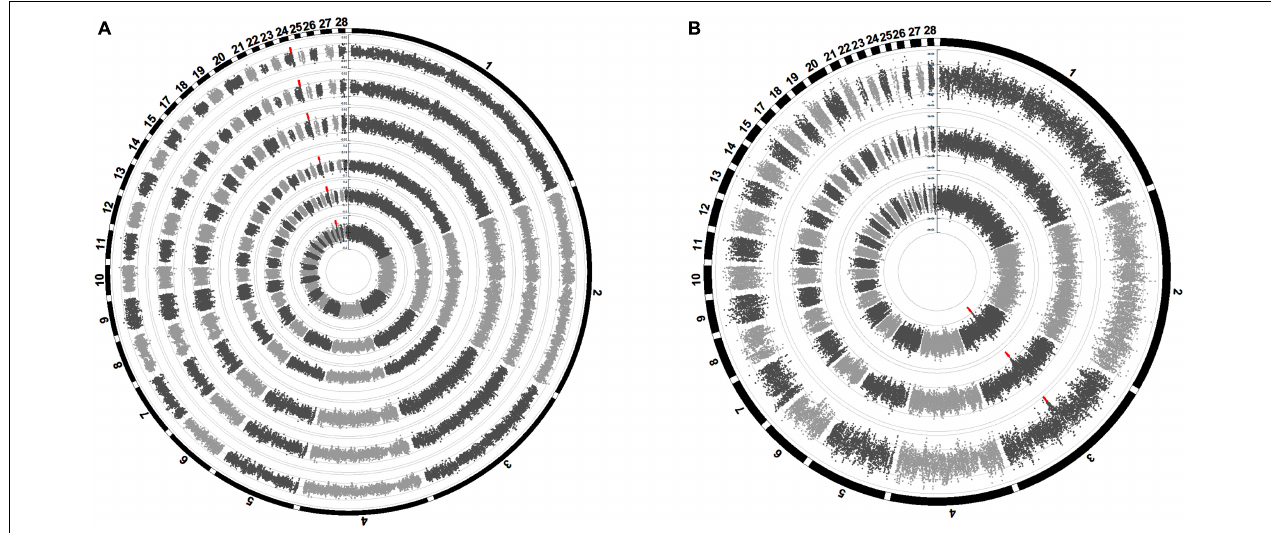
FIGURE 5 | Manhattan plots of SNP effect sizes for the carcass traits (A) and carcass composition traits (B) . Each dot represents an SNP. The SNP effect sizes are shown on the y -axis. The circle Manhattan plots from the inside to the outside are BW42, CW, EW, WThW, ThW, ThMW, WThP, ThP, and ThMP. The SNPs highlighted in red are suggestively significant in